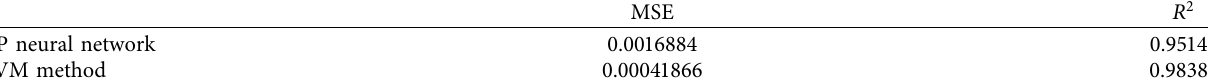
Table 2: Comparison of the SVM model and BP neural network.